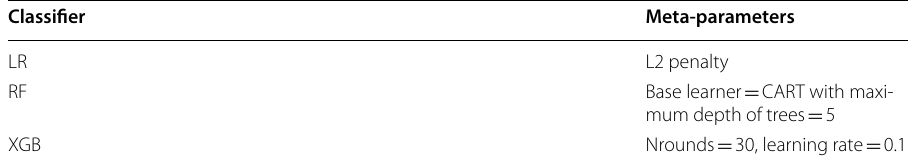
Table 18 Meta-parameters for each classifier Classifier